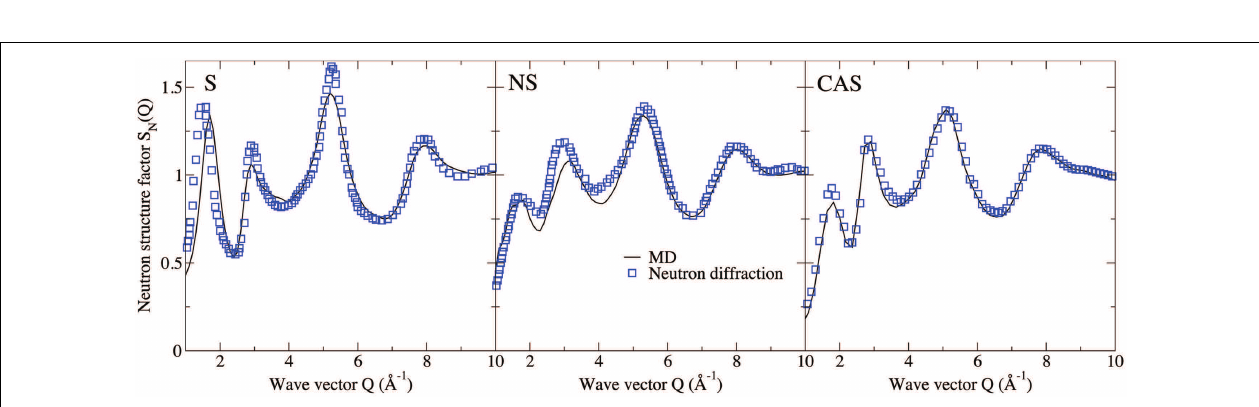
FIGURE 4 | Computed neutron structure factor of silica (S), sodium silicate (NS), and calcium aluminosilicate (CAS), compared with neutron diffraction measurements (Grimley et al., 1990;Wright et al., 1991; Cormier et al., 2000; Ganster et al., 2004).